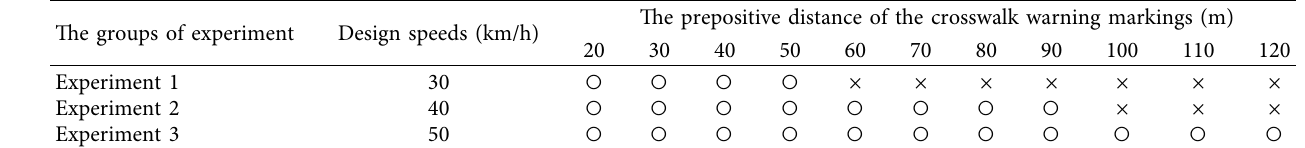
Figure 3: The UC-win/Road simulation modelling. Table 3: The experiment groups.